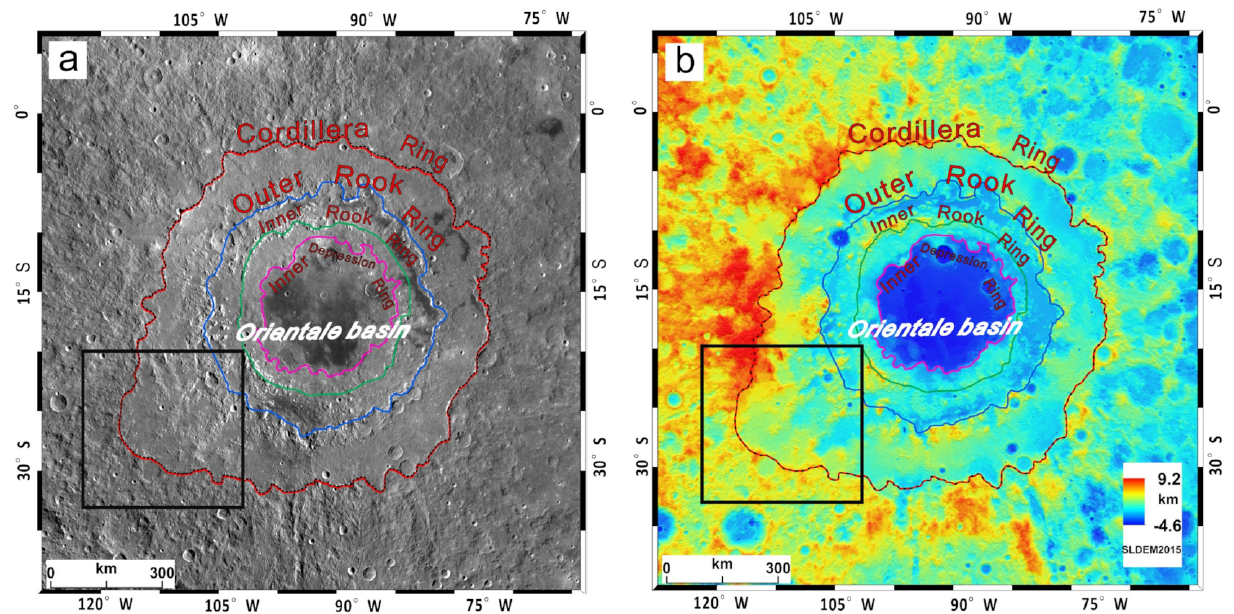
Figure 1. Ring configuration of the Orientale basin and black box is the study region: ( a ) WAC image mosaic; ( b ) SLDEM2015 colored gridded topography (orthographic projection centered at 19 ◦ S, 95 ◦